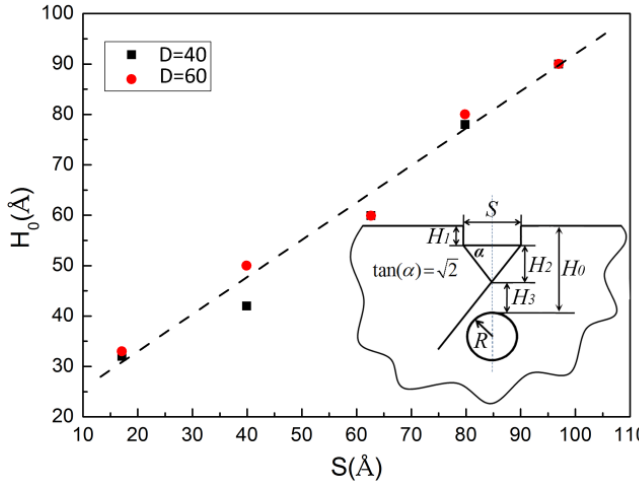
Figure 7. The relationship between the critical depth ( H 0 ) and indenter size ( S ).